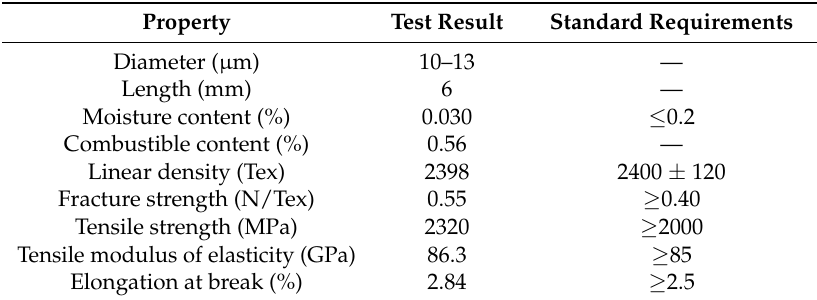
Table 2. Technical properties of basalt fiber.